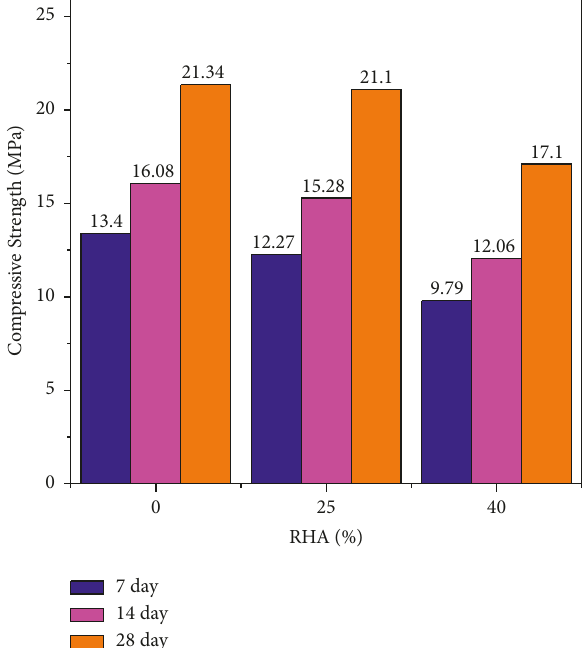
Figure 21: Compressive strength of concrete with SP [56].